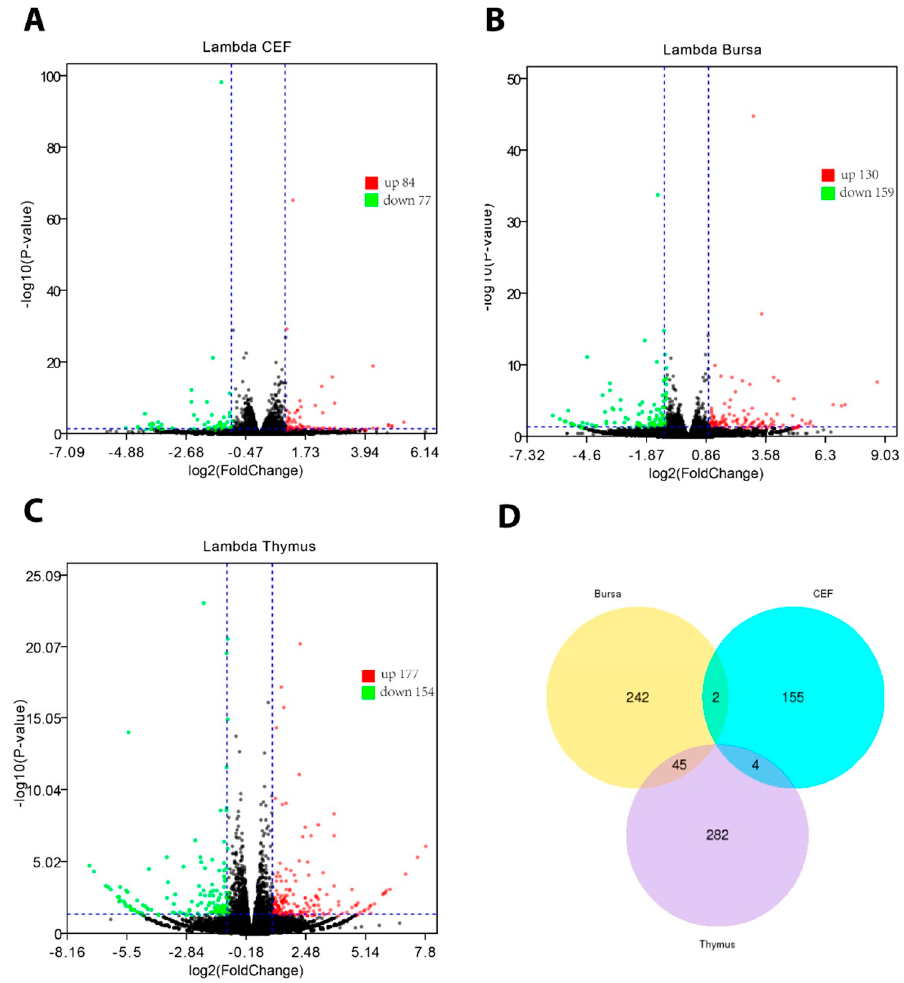
Figure 2. Gene expression representation by volcano plot diagrams and Venn diagram. A : Differentially expressed genes (DEGs) in chIFN- λ -treated chicken embryo fibroblasts (CEF). B : DEGs in chIFN- λ -treated bursa of Fabricius. C : DEGs in chIFN- λ -treated thymus. D : Venn diagram representing gene sharing. Red, green, and blue dots represent upregulated, downregulated, and sum of DEGs, respectively. Differential expression patterns demonstrate the temporal expression of genes expressed in the three groups.